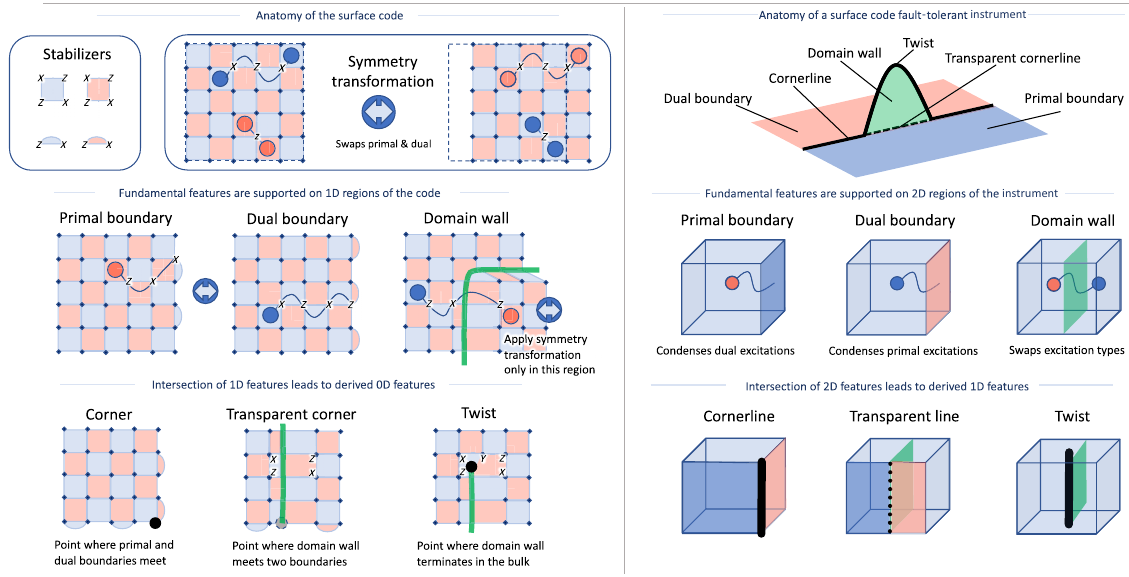
FIG. 4. Left: topological features in two dimensions and their relationship to the Z 2 primal-dual symmetry transformation. Primal (dual) anyonic excitations are created on primal (dual) plaquettes at the end of open dual (primal) string operators. The symmetry swaps primal and dual stabilizer checks, and anyonic excitations. Primal boundaries absorb dual-type excitations, dual boundaries absorb primal-type excitations. Primal and dual anyons are swapped upon crossing a domain wall. Corners and transparent corners appear on the interface between primal and dual boundaries in the absence and presence of domain walls, respectively. Twists appear on the boundary of domain walls (with the corresponding stabilizer shown). Right: the ( 2 + 1 ) depiction of topological features and their relationships. Twists and corners are two different manifestations of the same object. Their location is physical and has observable consequences. In contrast, transparent domain walls and corners can be relocated and simply correspond to a book-keeping gauge